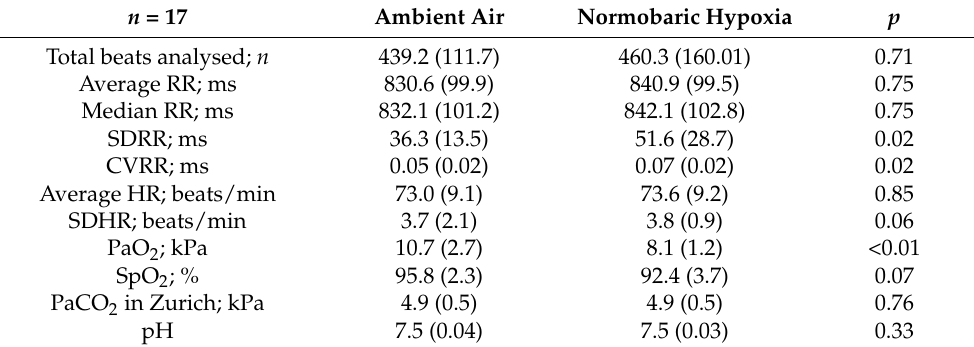
Table 3. Other HRV parameters, HR and blood gas parameters in ambient air and normobaric hypoxia. n = 17 Ambient Air Normobaric